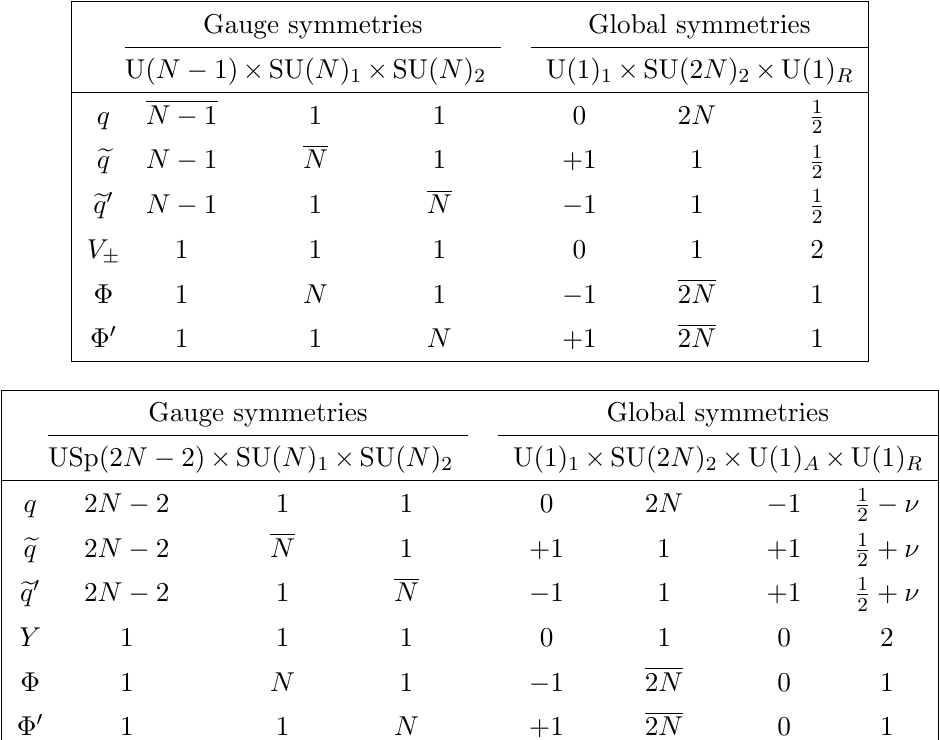
Table 2 . Charges of 3d and 4d (cid:12)elds under unbroken symmetries for the two descriptions of the S-duality domain wall in (5.1). First we list gauge groups of the 3d theory and 4d theories, then (cid:13)avour and R -symmetry groups. Charges coincide except for the additional symmetry U(1) A in the second case, and the possibility to mix it into the R -symmetry for some parameter (cid:23) with j (cid:23) j (cid:20) 1 = 4.